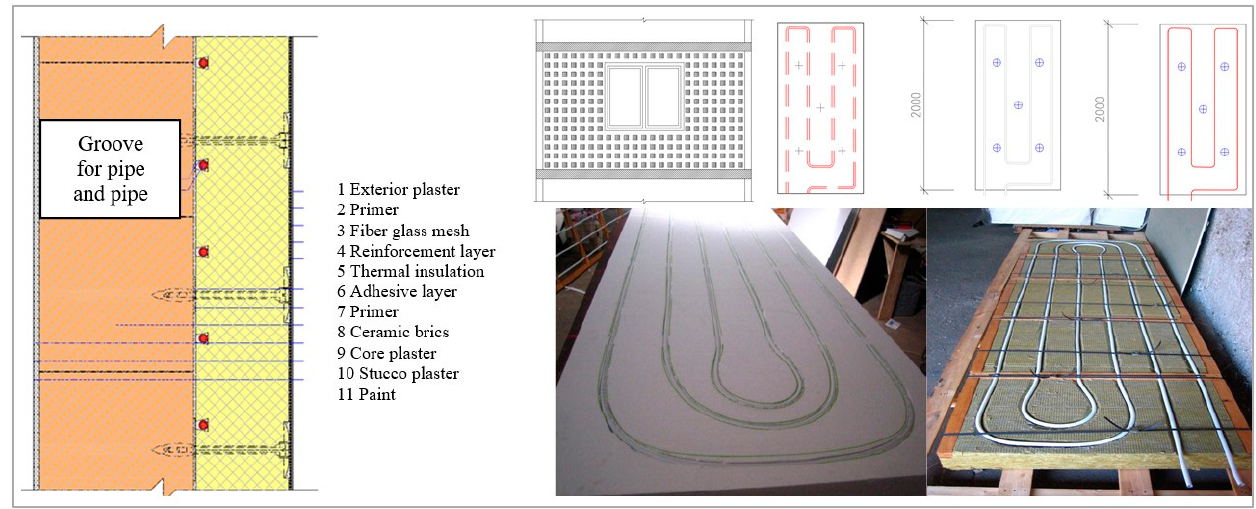
Figure 21. Application of contact thermal insulation system using thermal insulation panels and prototypes of thermal insulation panels ATP—EPS and mineral wool [23,33,34].